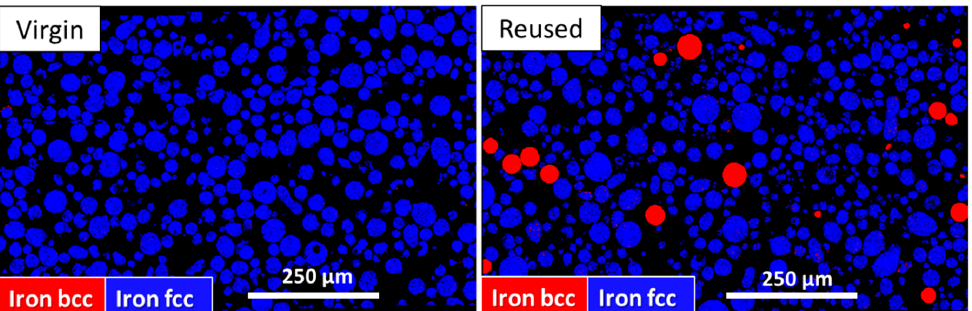
Figure 9. Electron backscatter diffraction (EBSD) phase maps and inverse pole figure montage maps for fcc γ austenite (blue) and bcc δ ferrite (red) regions in virgin and reused powders. Adapted from Reference [37] with permission from Elsevier.